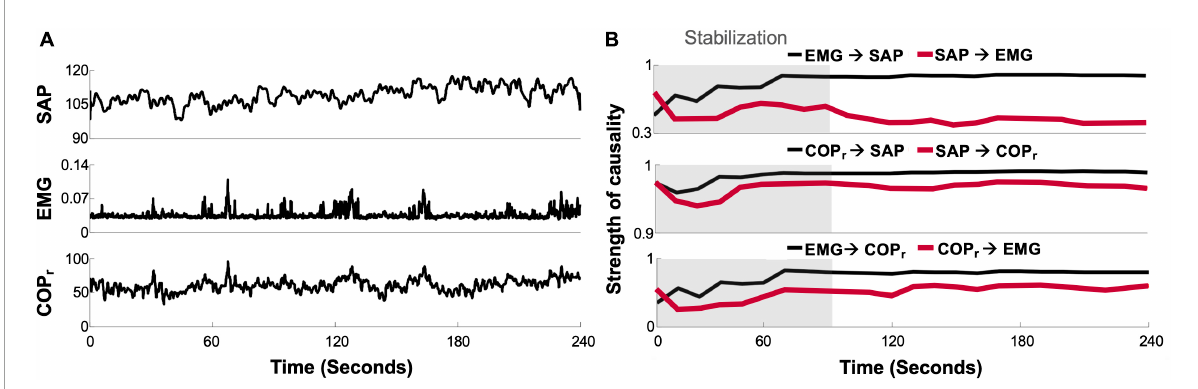
FIGURE9 Cardio-postural causality. (A) Example tracing of simultaneously recorded systolic arterial pressure (SAP), calf electromyography (EMG), and center of pressure (COPr) signals. (B) Convergence plot of causality between signals over time during a quiet upright standing trial. Causality between signals, as calculated from the convergent cross mapping method (130, 135, 136), was measured on a scale between 0 and 1 (unitless). Gray shading indicates stabilization period following upright stance. Adapted from Verma et al.